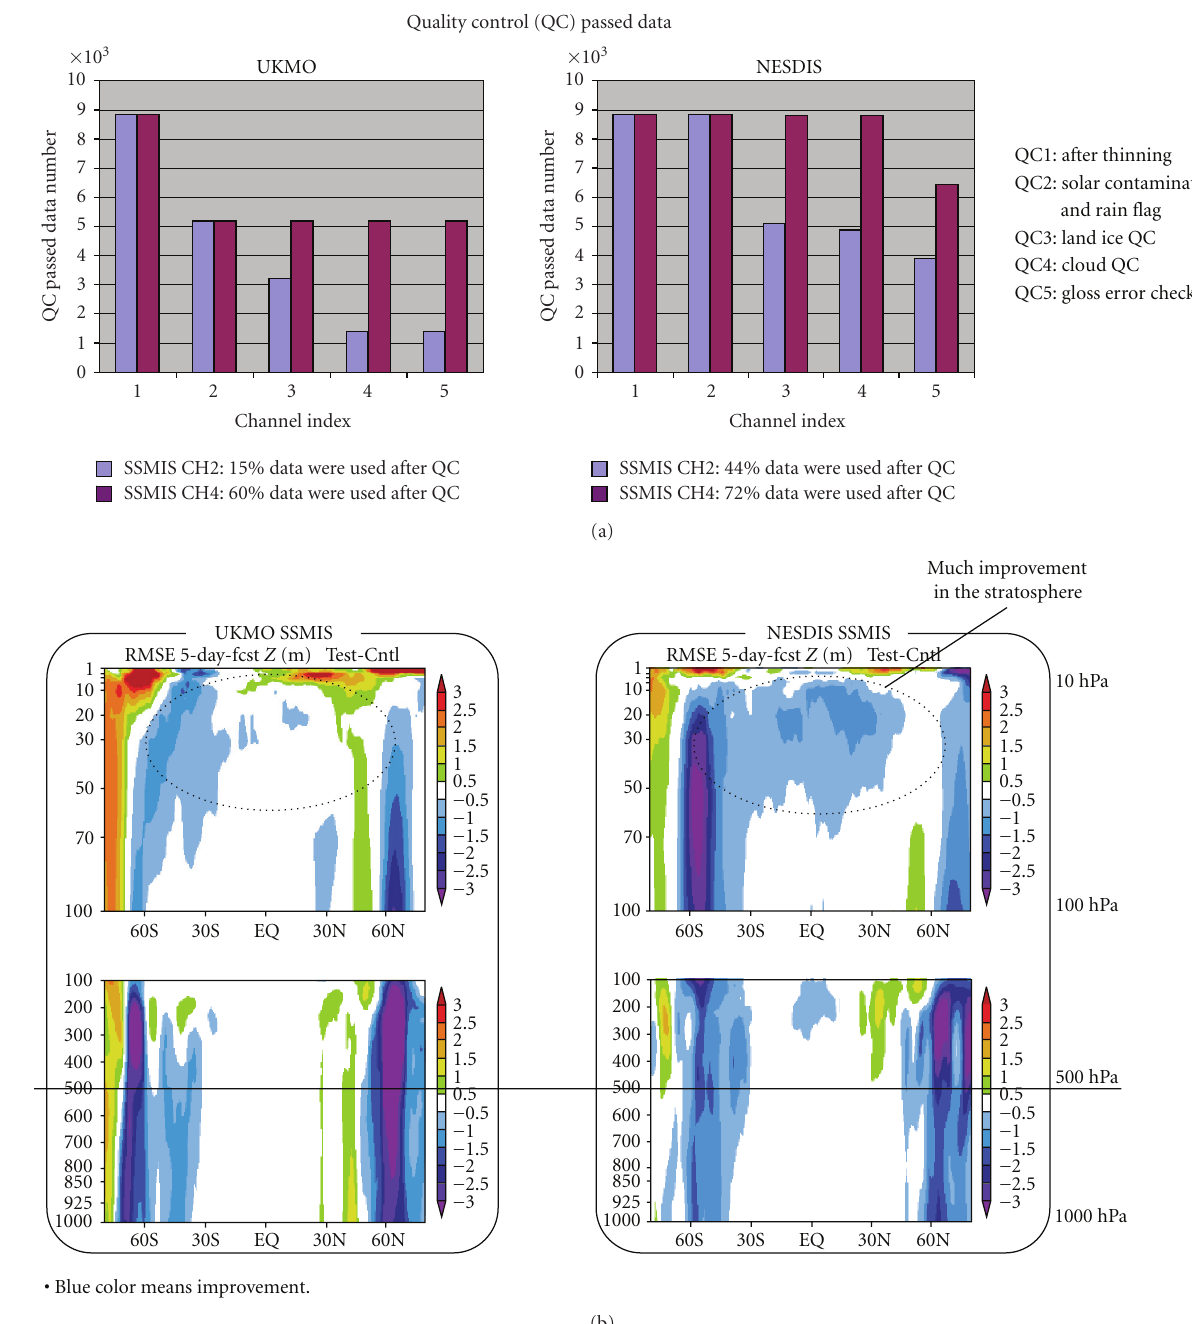
Figure 13: (a) Number of the SSMIS data from channel 1 to channel 4 for three orbits of observations used in the NCEP global forecast model, on August 9, 2006. (b) Vertical distribution of root mean square error (RMSE) di ff erence in the predicted geopotential height along latitude between the five days of assimilation experiments of “Cntl” and “Test” by using the NCEP global forecast model (Courtesy to Masahiro